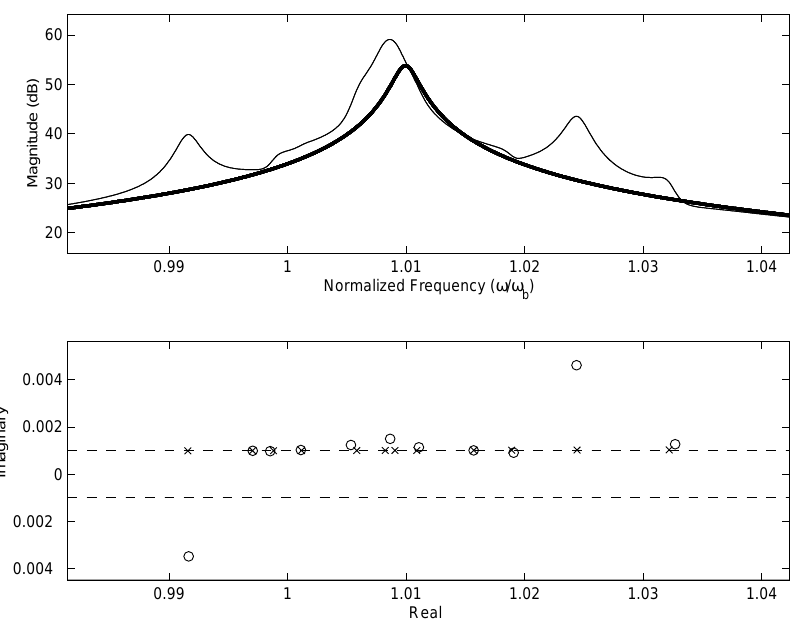
Fig. 6. Largest Amplification Mistuning Pattern (A=1.84, E=3). a) Maximum Blade FRF. — tuned, — mistuned. b) Pole/Zero Map. × poles, ◦ zeros. Zeros between the dashed lines reduce the response more than the poles amplify it.